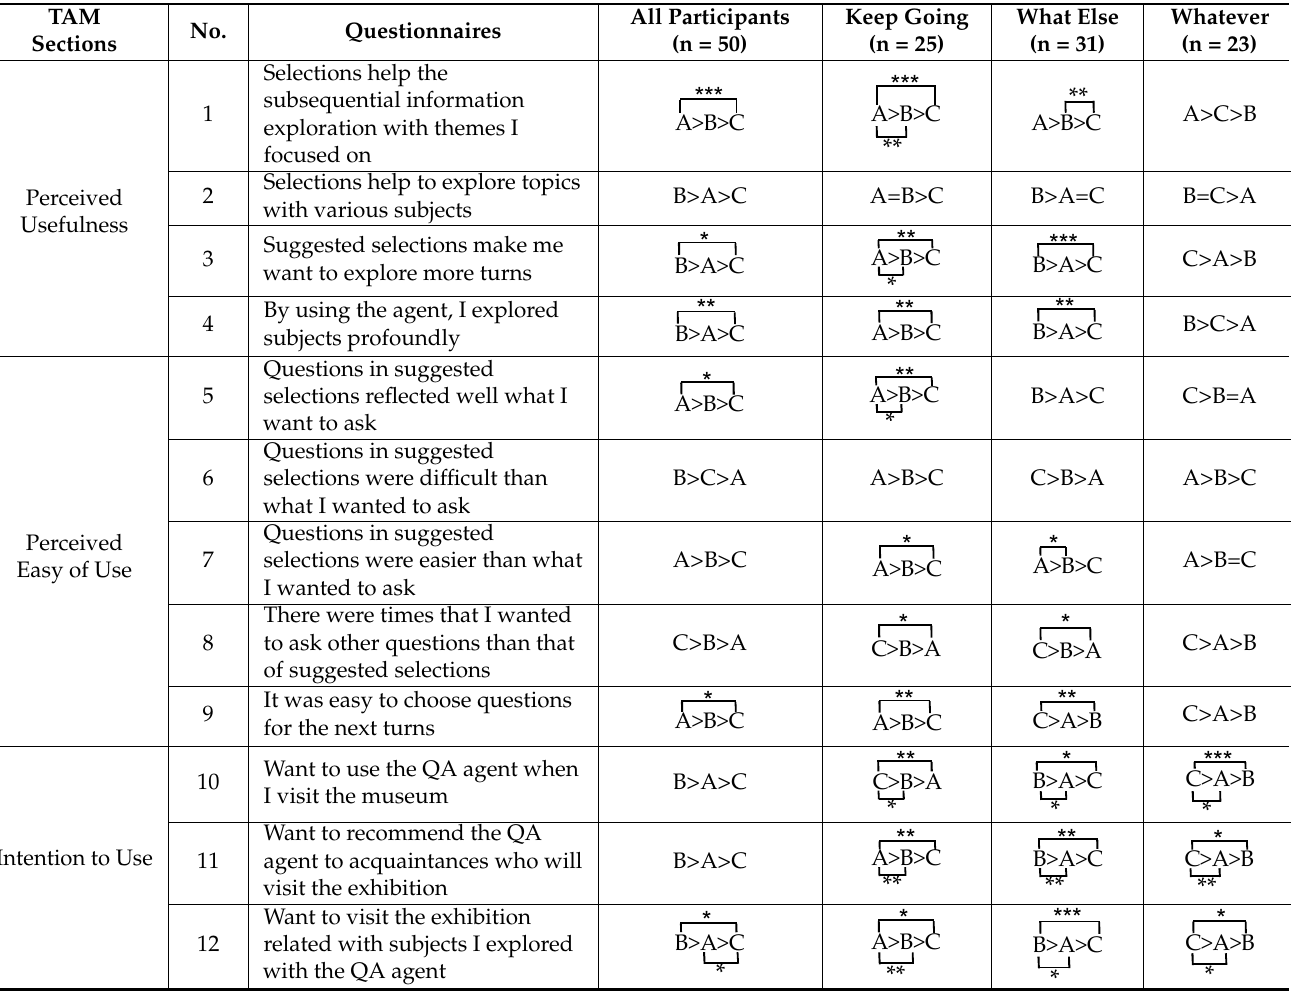
Table 2. Results from questionnaire after using each model.